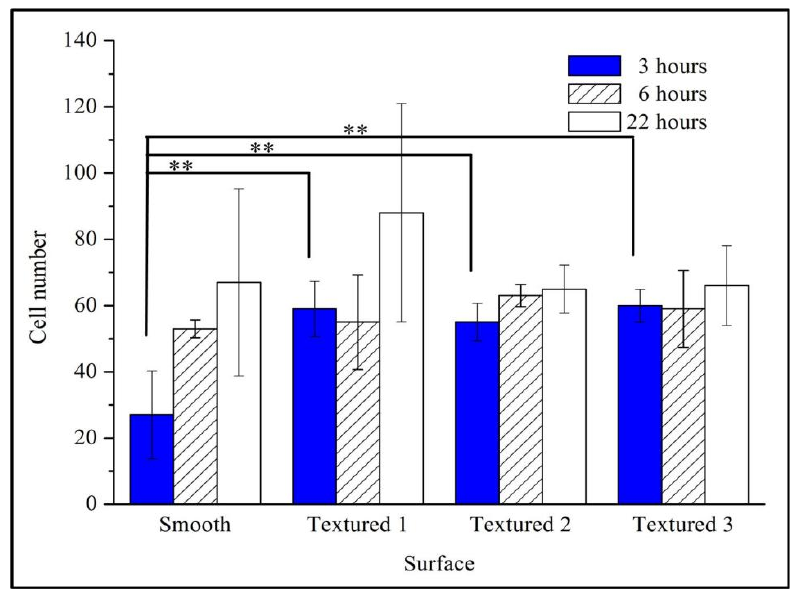
Figure 10. The final results of MC3T3-E1 cell numbers after 3 h, 6 h, and 22 h of growth. Smooth; Texture 1; Texture 2; and Texture 3. ** p < 0.01, versus smooth surface.